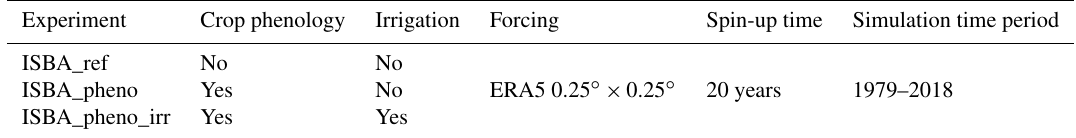
Table 2. Main set-up of the three 40-year evaluation experiments driven by ERA5 atmospheric variables over Nebraska. Crop phenology is defined by emergence and harvest dates, while irrigation corresponds to additional water supply.